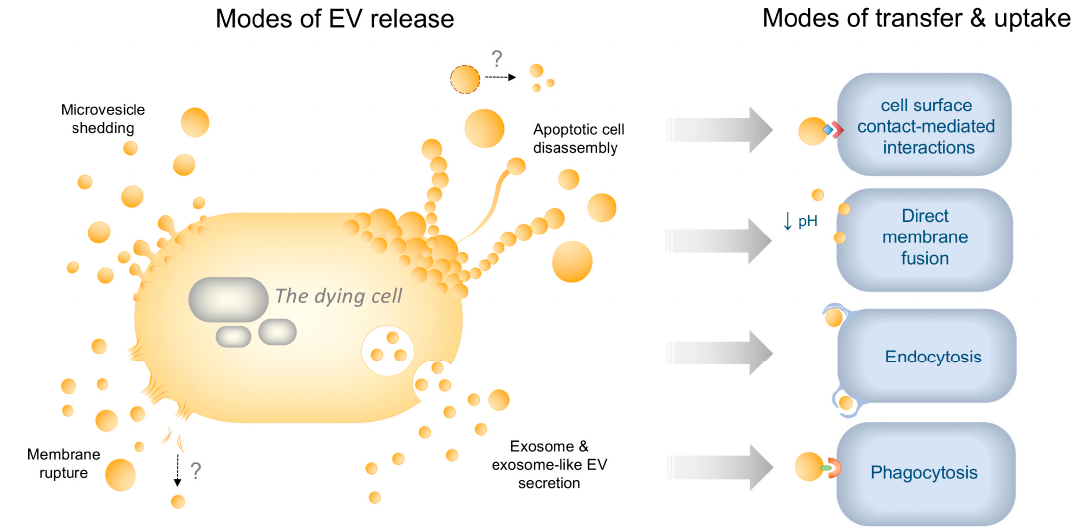
Figure 1. Modes of dying-cell-derived extracellular vesicle (EV) release and transfer to recipient cells. Dying cells can release EVs via a number of di ff erent mechanisms: (i) Microvesicle (MV) shedding involves the budding and release of MV (10–1000 nm) from the plasma membrane through Ca 2 + mediated cytoskeletal changes; (ii) apoptotic cell disassembly induces the formation of apoptotic bodies (ApoBDs; 1–5 µ m) released via caspase-dependent blebbing and protrusion formation during